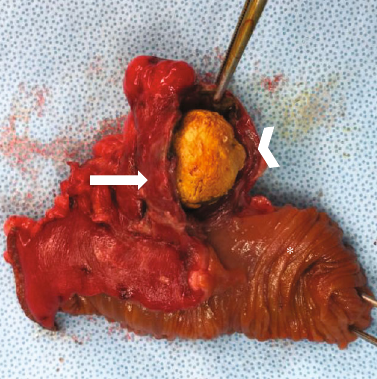
Figure 3: Surgical specimen: intestinal segment (asterisk), Meckel diverticulum (white arrow), and intradiverticular calculus (white